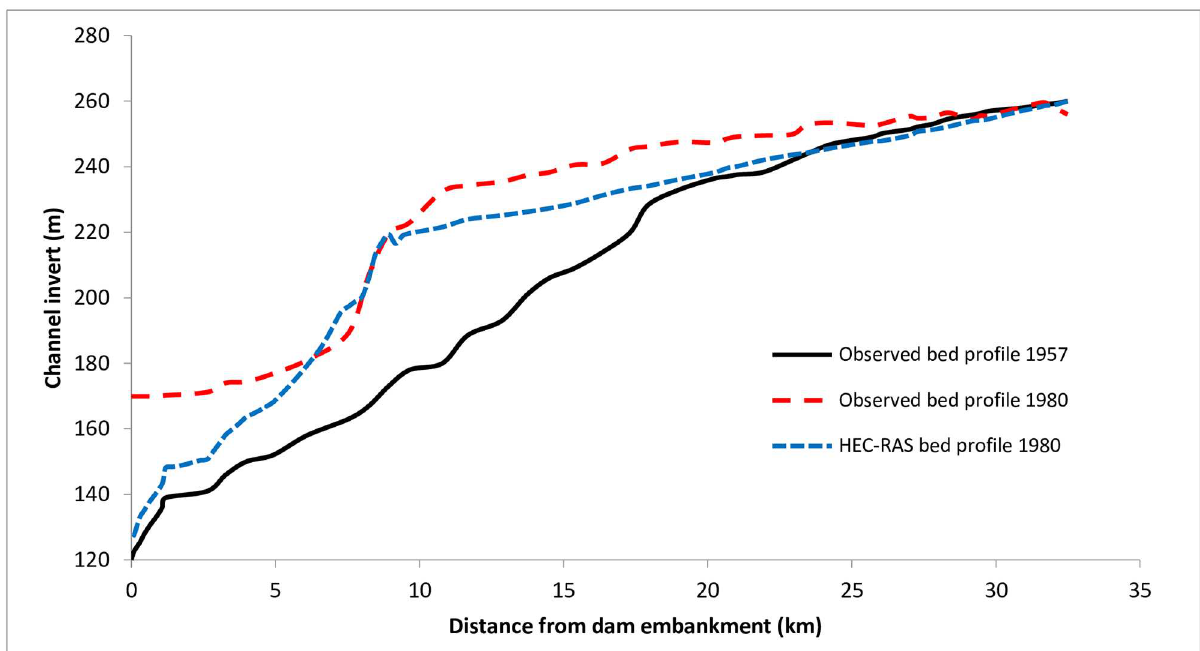
Fig 5. Comparison between observed and HEC-RAS bed profile of 1980 after